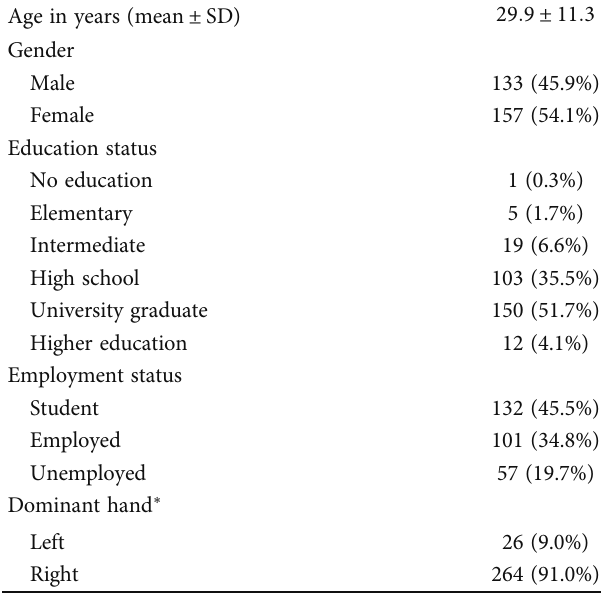
Table 1: Participants ’ characteristics; n = 290